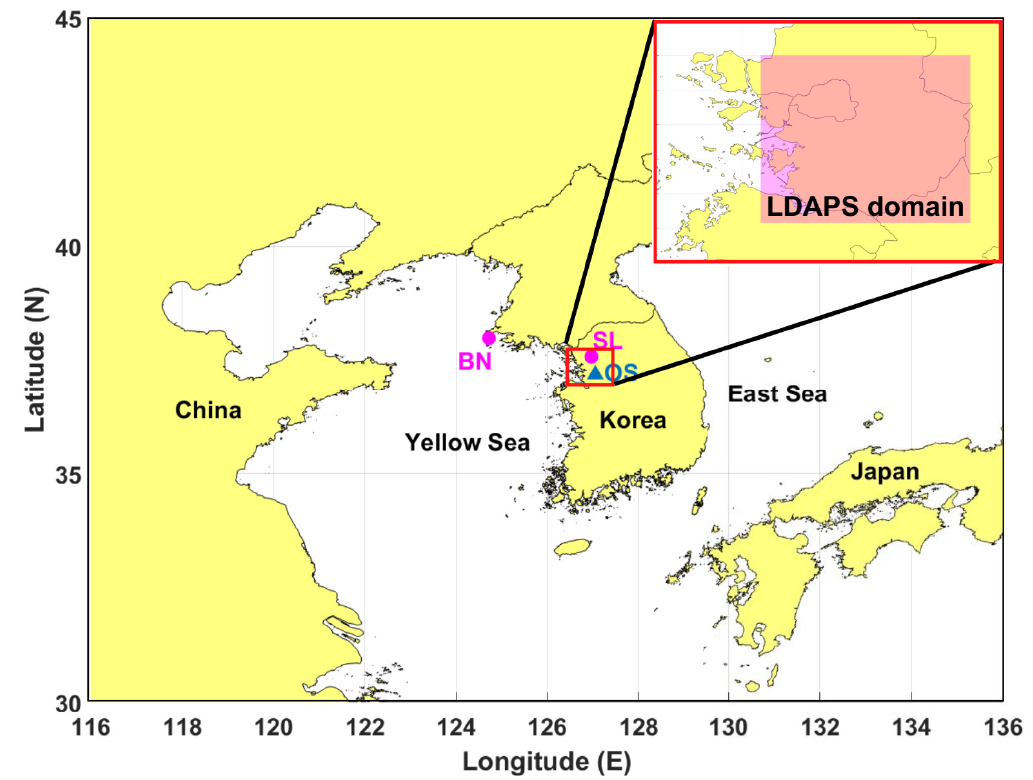
Figure 1. Location of two main sites (magenta circle) used in this study. Red rectangle indicates the analyzed domain (36.8–37.8 N, 126.4–127.8 E) of LDAPS. Blue triangle denotes Osan (OS) station launching rawinsonde four times a day. LDAPS indicates Local Data Assimilation and Prediction System.